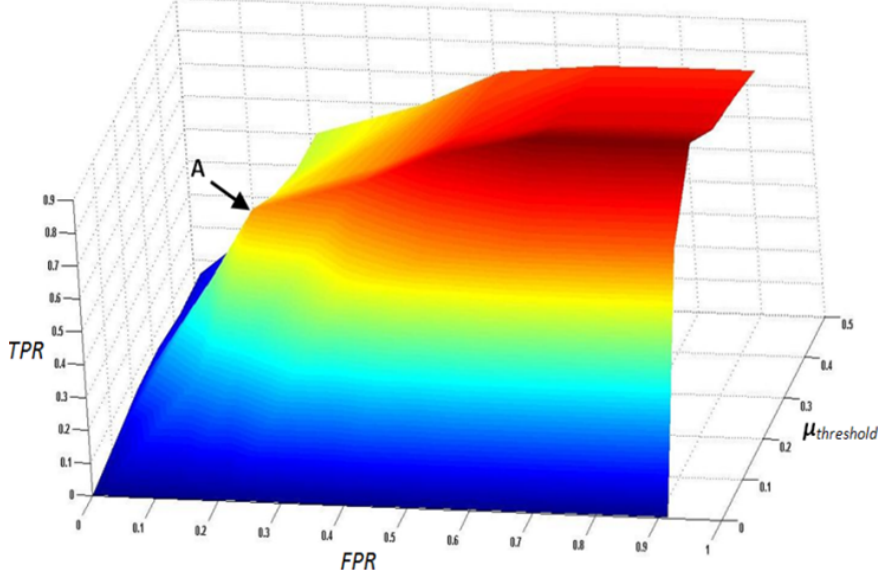
Figure 16. True positive rate (TPR) is plotted against false positive rate (FPR) to obtain a 3D Receiver Operating Characteristic (ROC) curve for neighborhood-1 (modified). Point A on the surface represents the optimal/best